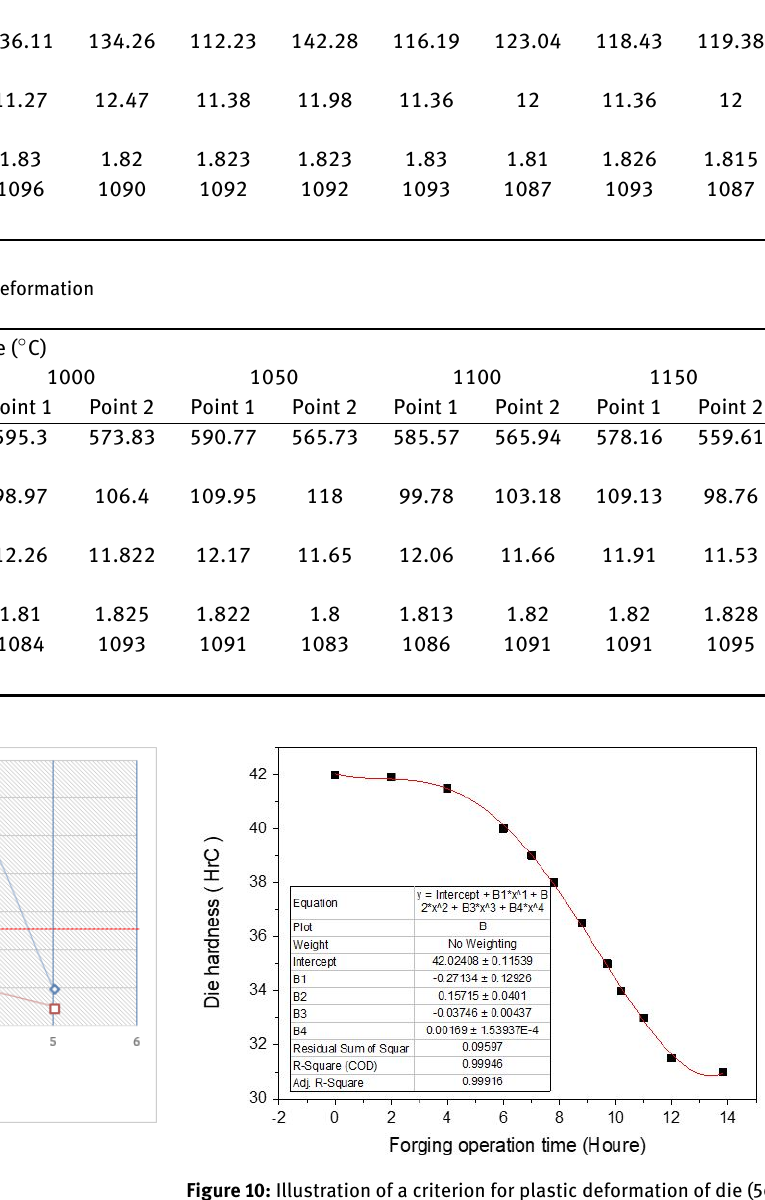
Figure 10: Illustration of a criterion for plastic deformation of die